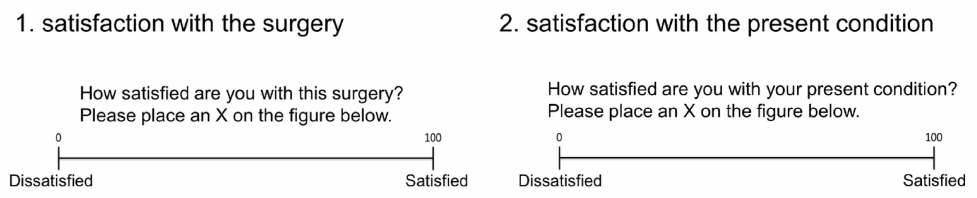
Figure 1. Methods of assessing patient satisfaction. Patient satisfaction was evaluated based on two parameters: satisfaction with surgery and satisfaction with the present condition, using the VAS (graded as ‘0’ for unsatisfied to ‘100’ points for very satisfied) at 1 year postoperatively. The survey was conducted by